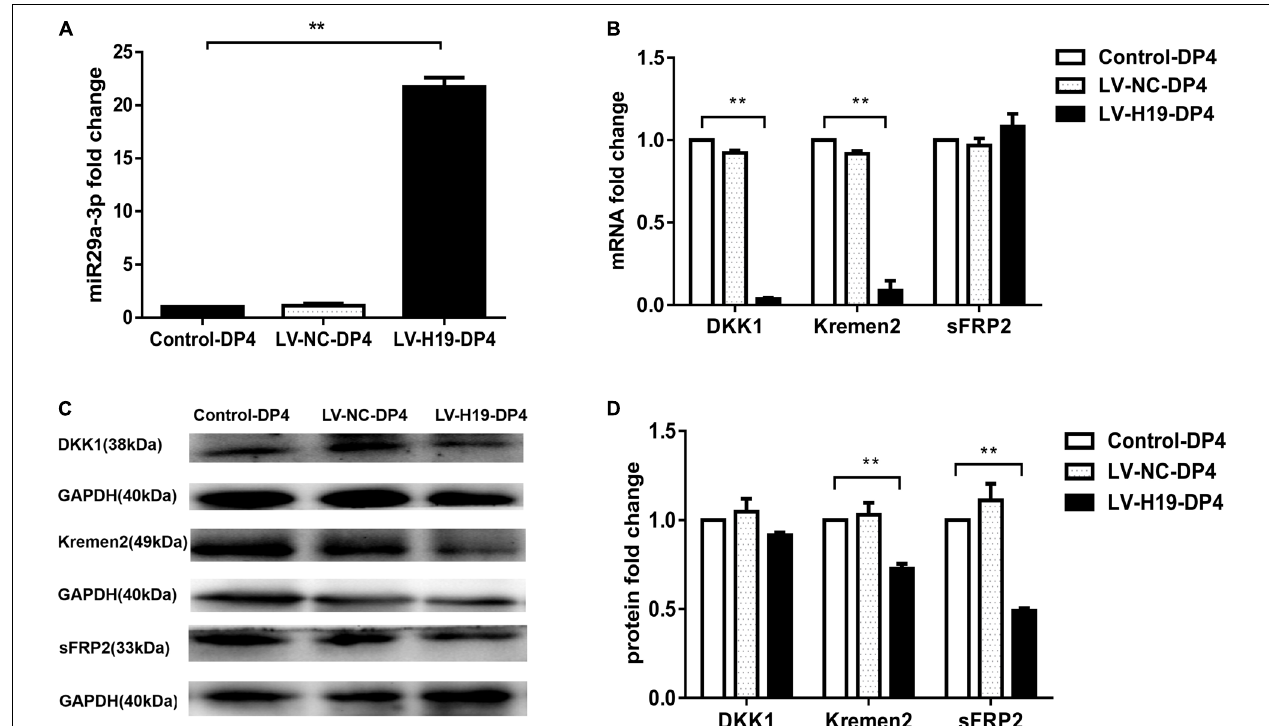
FIGURE 4 | Overexpression of H19 upregulates miR-29a and reduces the expression of its target gene involvement in Wnt signaling in skin of NU/NU mice. (A) Injection of DP4 cells transfected with LV-H19 uprelated the level of miR-29a-3 in the skin. (B) QPCR showed that DKK1 and Kremen2 were down-regulated, but sFRP2 mRNA expression slightly increased following transduction of DP4 cells with LV-H19. (C) LncRNAH19 overexpression significantly decreased Kremen2, and sFRP2 protein levels, while the level of DKK1 was reduced slightly in the skin. (D) Dkk1, Kremen2, and sFRP2 protein expression levels were quantified. Data shown represent the mean ± SEM of three independent experiments. ** P <